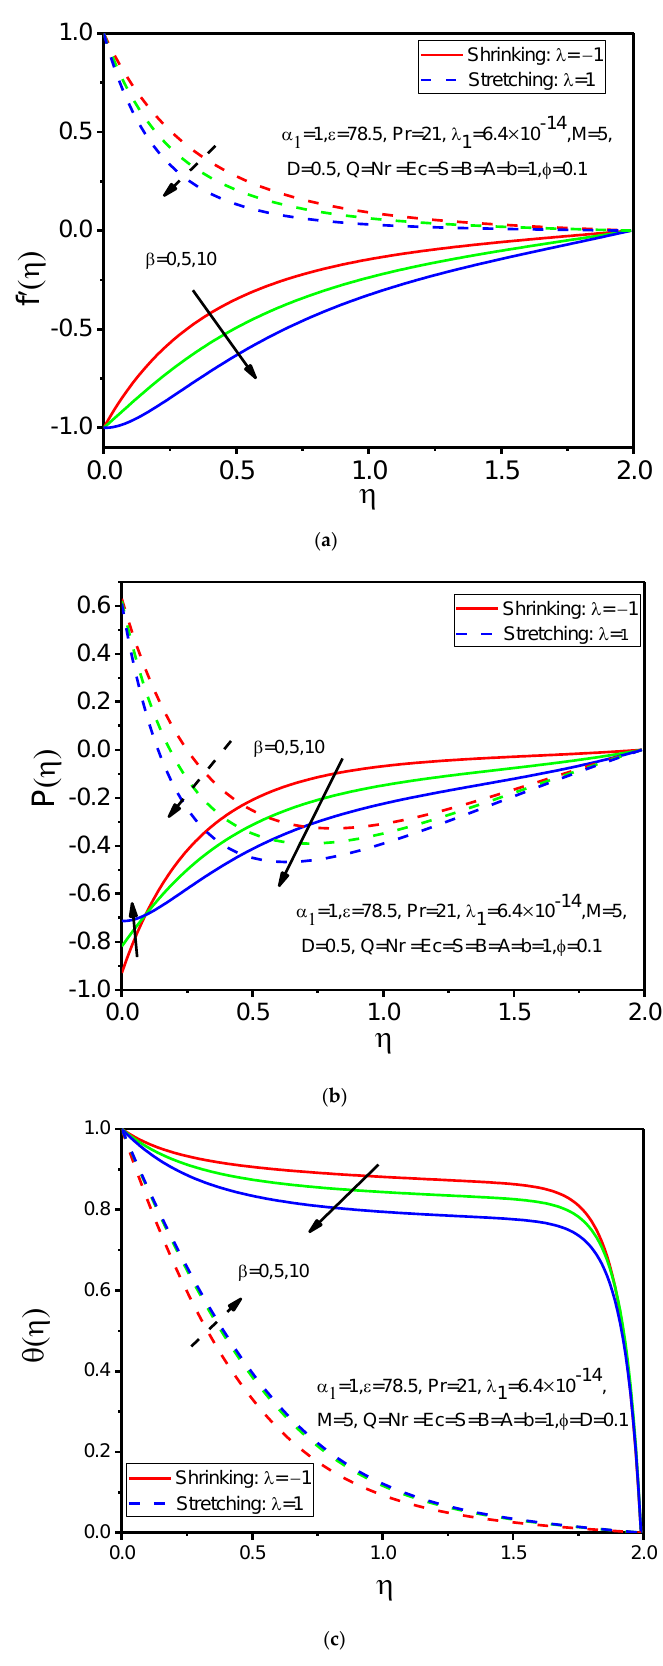
Figure 5. Variation of β on ( a ) velocity profile, ( b ) Pressure profile, ( c ) Temperature